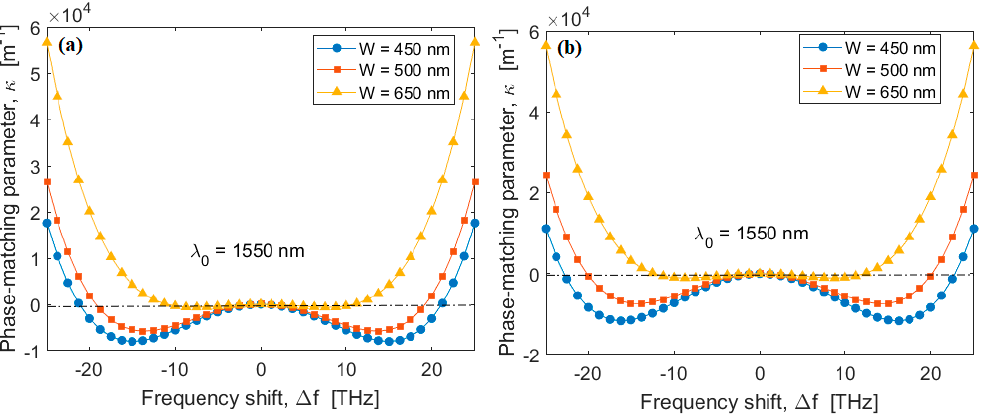
Figure 4. Phase matching parameter as a function of the frequency shift for different values of the SOI waveguide width. ( a ) 𝐻 = 220 nm; ( b ) 𝐻 = 250 nm.